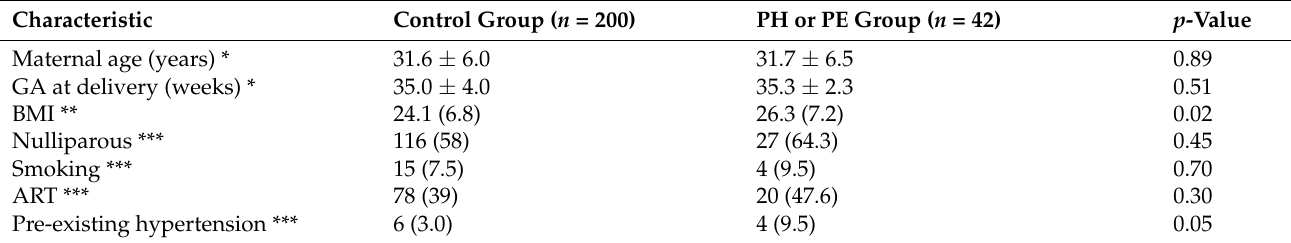
Table 1. Demographic and clinical characteristics of the control and study